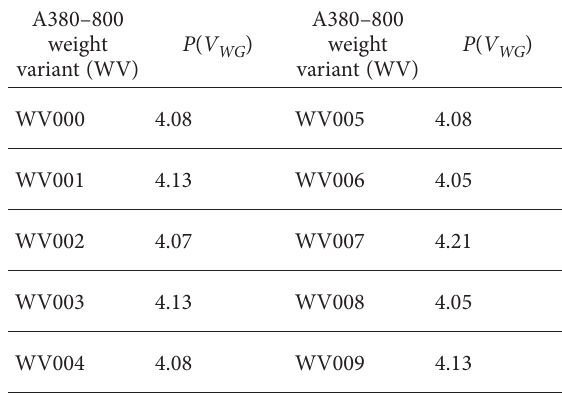
Table 1. Probability factor P ( V WG